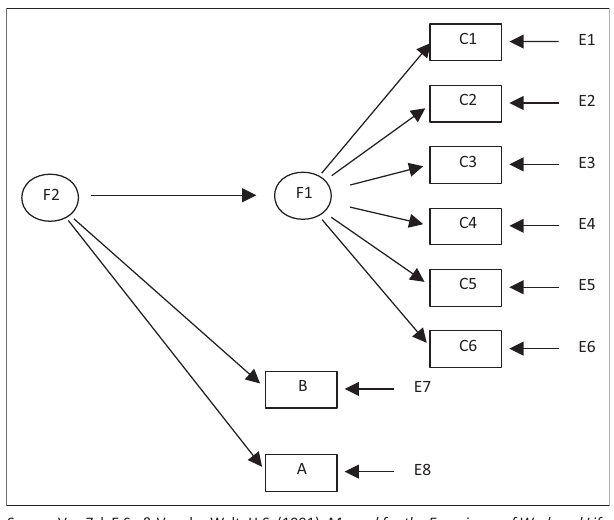
FIGURE 2: Hypothesised higher-order latent variable structural model of the Experience of Work and Life Circumstances